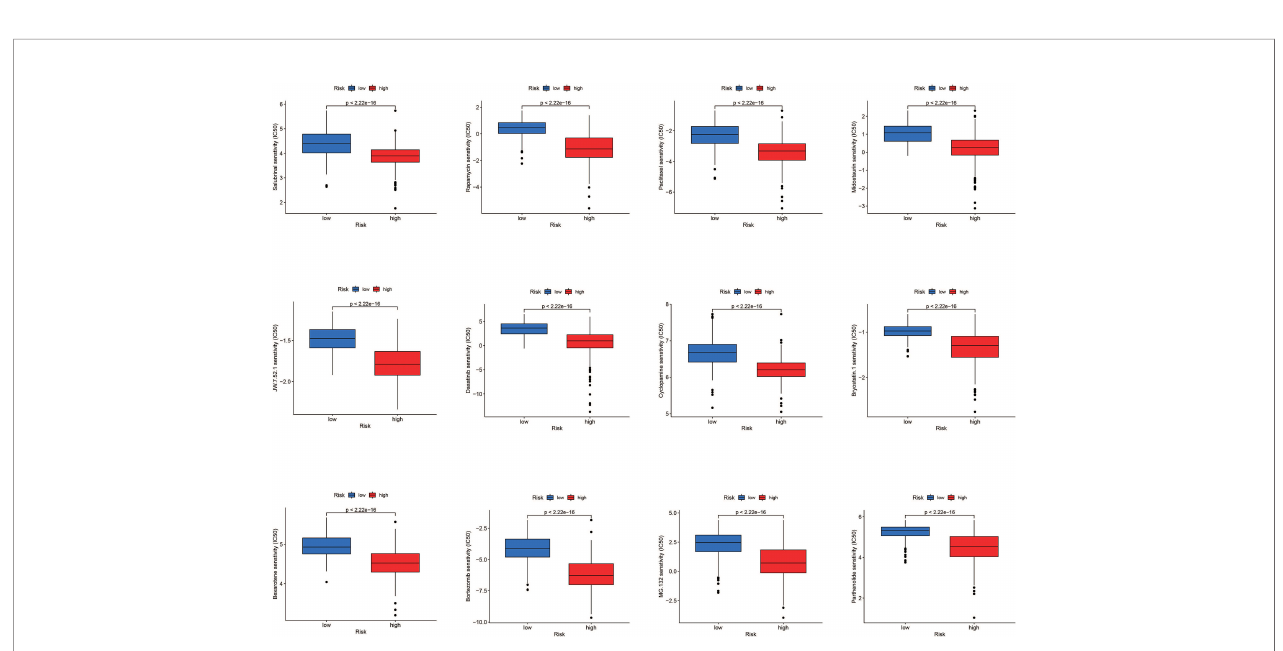
FIGURE 9 | Drug sensitivity analysis. Salubrinal, rapamycin, paclitaxel, midostaurim, JW.7.52.1, dasatinib, cyclopamine, bryostatin.1, bexarotene, bortezomib, MG.132, and parthenolide had a lower IC50 in the high-risk group, meaning the high-risk group was more sensitive to these